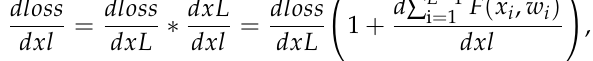
( b ) Figure 12. The impact of cross-domain on gesture recognition: ( a ) The effect of different environ- ments on gestures. ( b ) The effect of device distance on gestures.